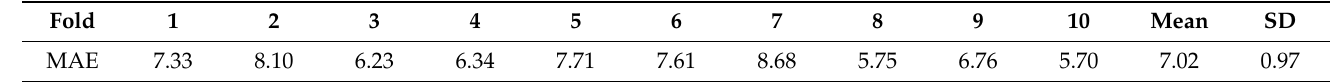
Table 5. Combined mean absolute error (MAE) and mean and standard deviation of the 10-fold cross- validation for the prediction of all target values using our best performing decision tree regressor model.